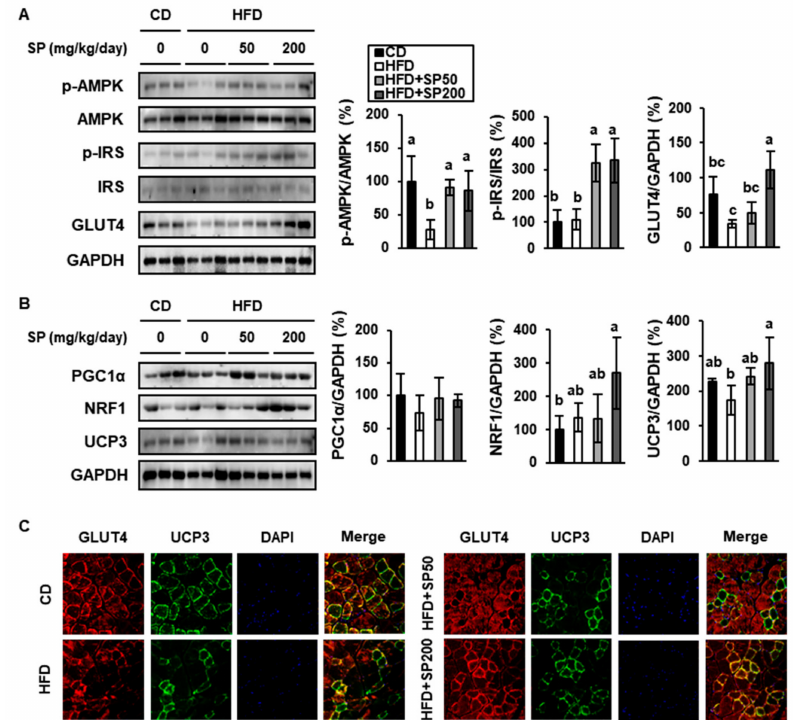
Figure 5. E ff ect of silk peptide on proteins involved in glucose uptake and mitochondrial metabolism in muscle from high-fat diet-fed mice. ( A ) Expression of proteins involved in glucose uptake (p-AMPK, AMPK, p-IRS, IRS, and GLUT4) was determined by western blotting. ( B ) Expression of proteins involved in mitochondrial biogenesis (PGC1 α , NRF1, and UCP3) was determined by western blotting. ( C ) Immunofluorescence images of muscles were captured at 400 × magnification. Muscles were fixed with methanol, and then anti-GLUT4 or anti-UCP3 antibodies and DAPI were applied. Data were analyzed using one-way ANOVA and Duncan’s test. Values with di ff erent letters are significantly di ff erent; p < 0.05 (a > b >